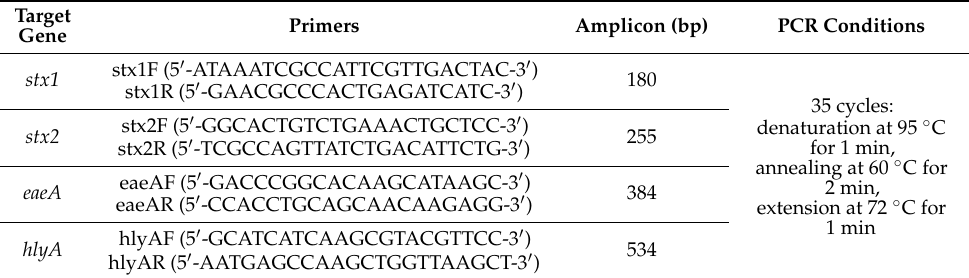
Table 1. Primers, investigated virulence genes, and expected amplicons of the PCR assays.